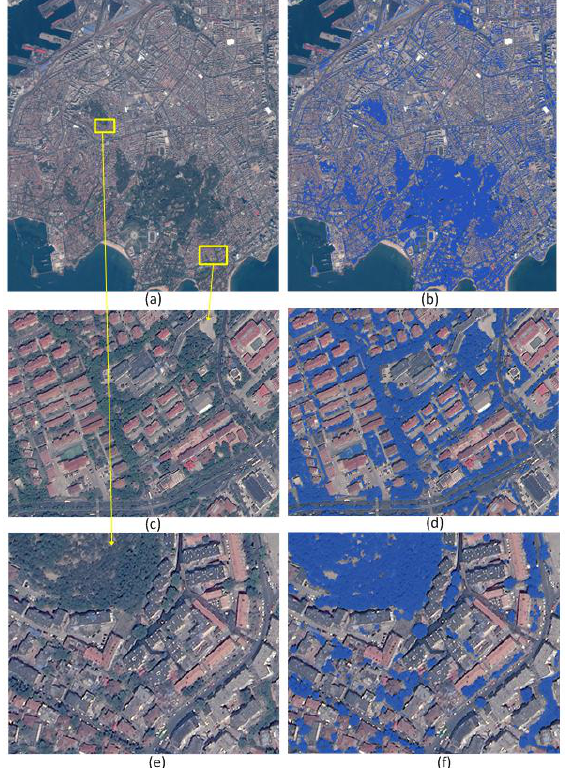
Figure 6. Greenery extraction result of GJ-1 image